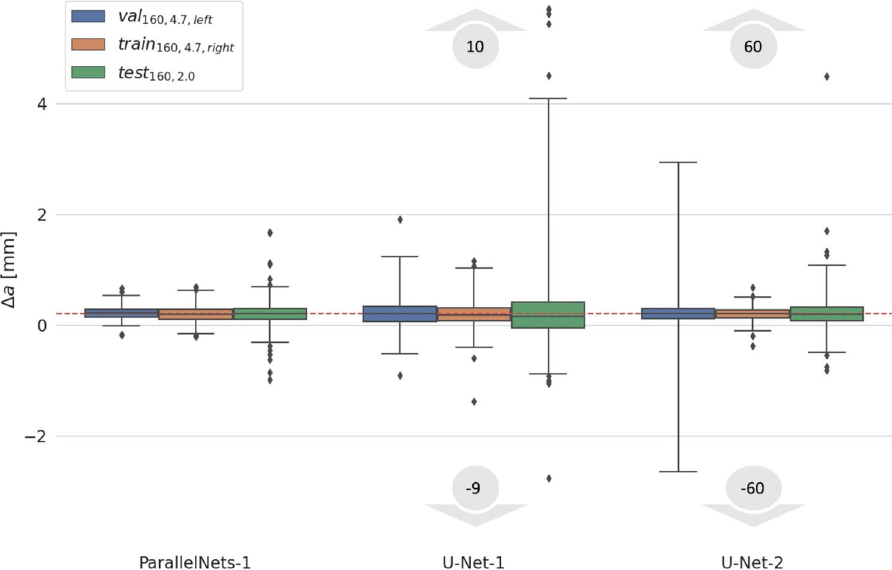
Figure 5. Stability of crack detection models between subsequent steps at maximal force. The target baseline for (cid:31) a is 0.2 mm depicted as a red dashed line. Quartiles (25–75%) are shown as colored boxes. The vertical black- line intervals indicate the 1–99% quantiles. Diamonds show outliers. For the models U-Net-1 and U-Net-2 these outliers actually range from − 9 to 10 and − 60 to 60 mm, respectively, and partially lie outside the plotted